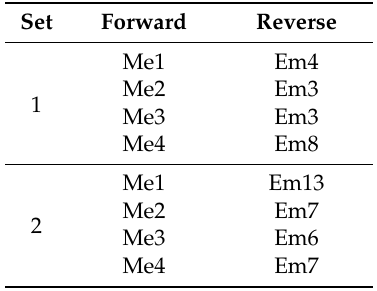
Table 3. Primer combinations used in the